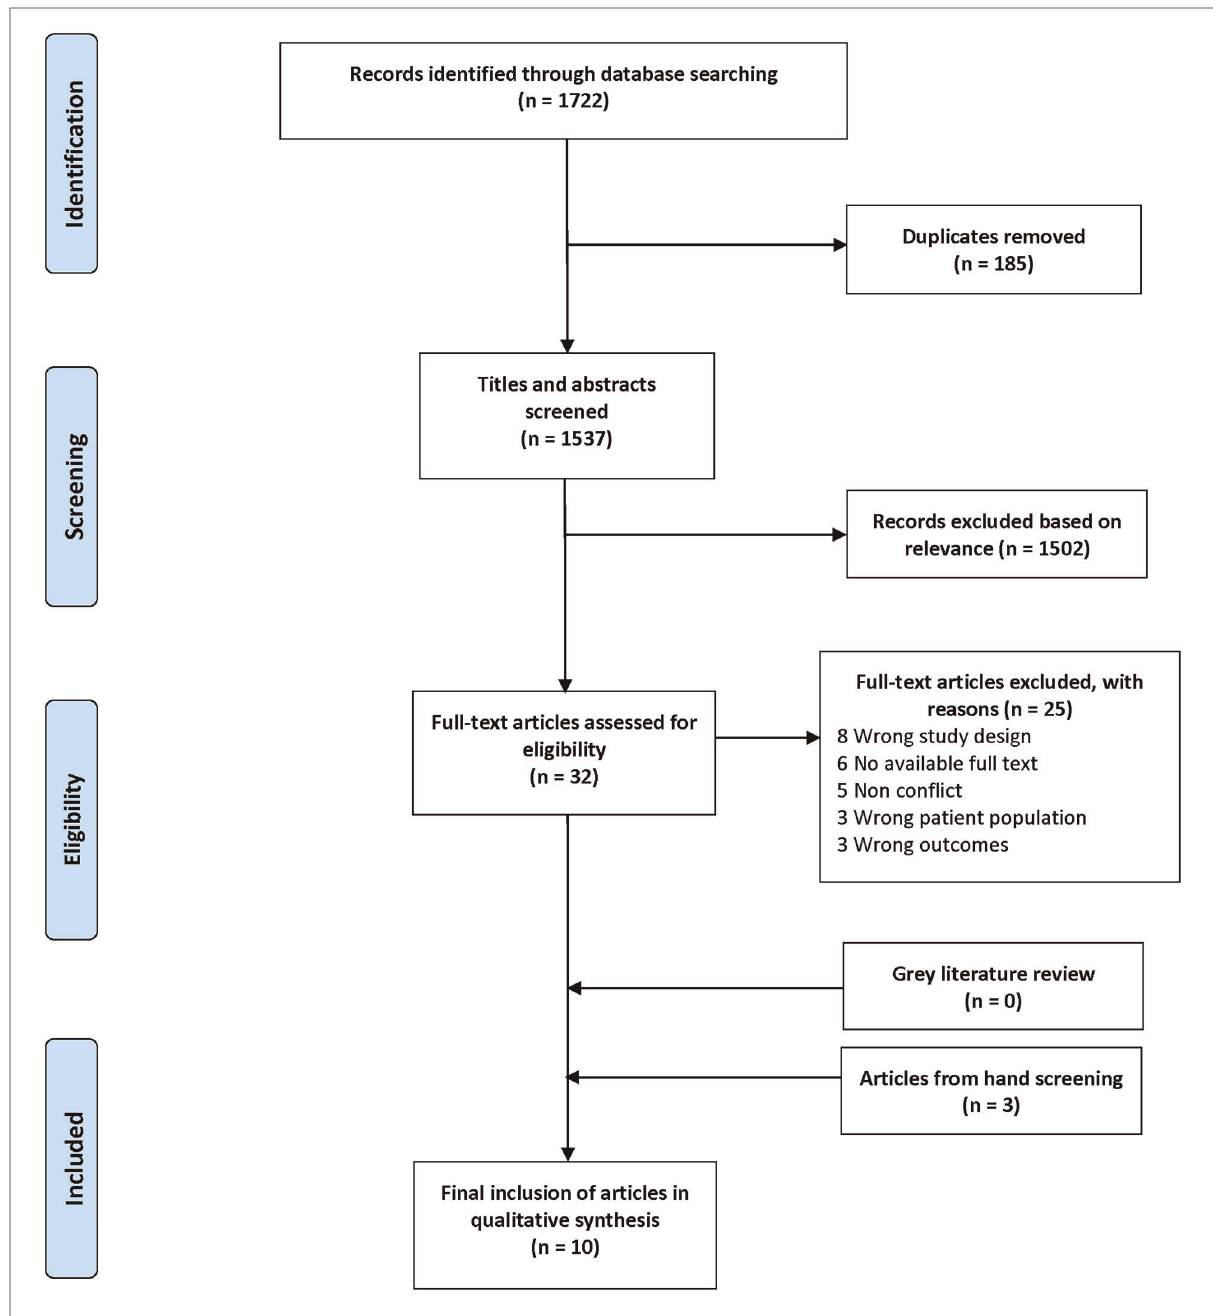
FIGURE 1 Flowchart of database search results and record